Question: Condense the content of this figure into a single sentence.
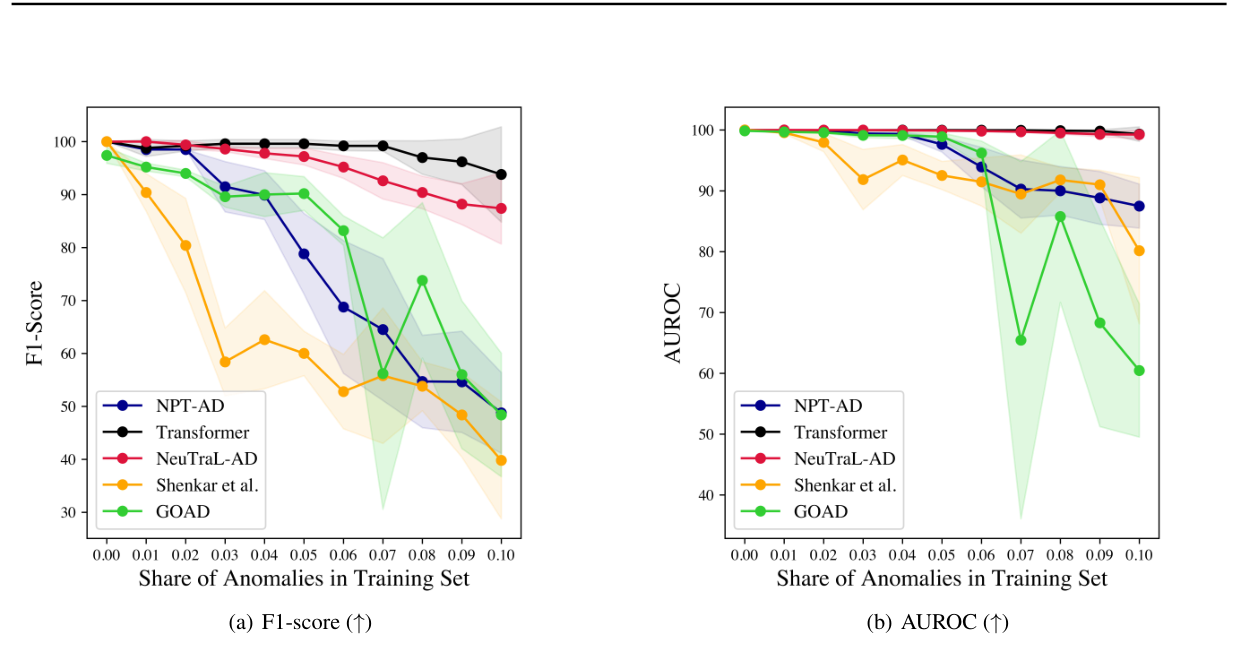
Answer: Training set contamination impact on the F1-score and AUROC. Each model was trained 5 times for each contamination share. The architecture used for NPT-AD is the same as for all experiments (see section 4). The NPT and Transformer were trained for 100 epochs with batch size equal to the dataset size, with learning rate 0.01, optimizer LAMB (You et al., 2020) with β = (0.9, 0.999), per-feature embedding dimension 16, r set to 1, and masking probability pmask = 0.15. NeuTraL-AD and GOAD were trained with hyperparameters as for the thyroid dataset in the original papers and (Shenkar & Wolf, 2022) with its default parameters in their implementation.